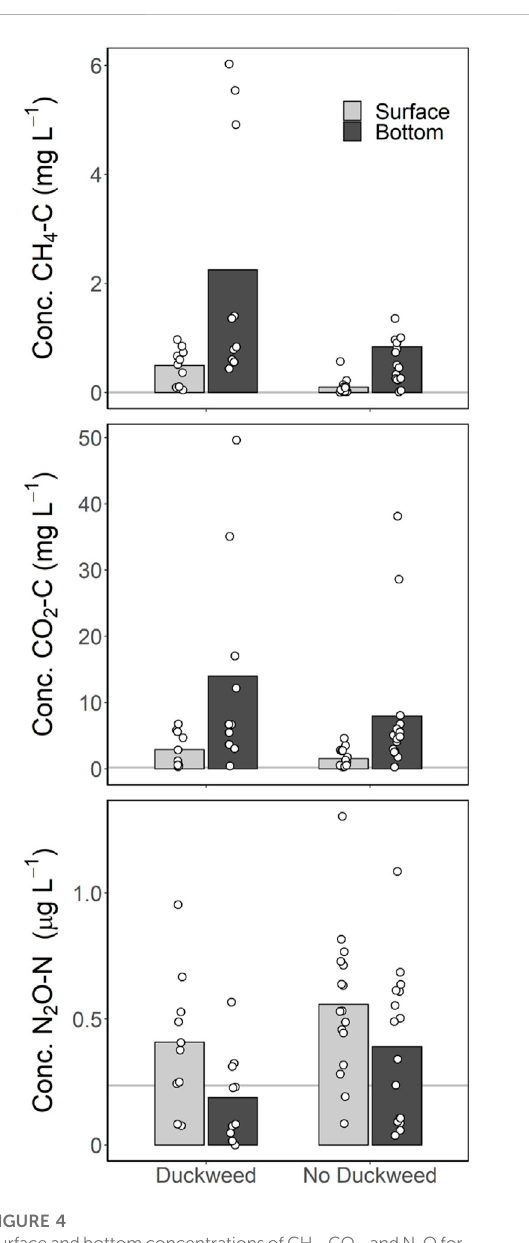
FIGURE 4 SurfaceandbottomconcentrationsofCH 4 ,CO 2 ,andN 2 Ofor duckweed and non-duckweed ponds. Signi fi cant differences between duckweed ponds and non-duckweed ponds are surface CH 4 concentration ( p = 0.0040), and bottom N 2 O concentration ( p = 0.043). Grey horizontal lines represent the equilibrium